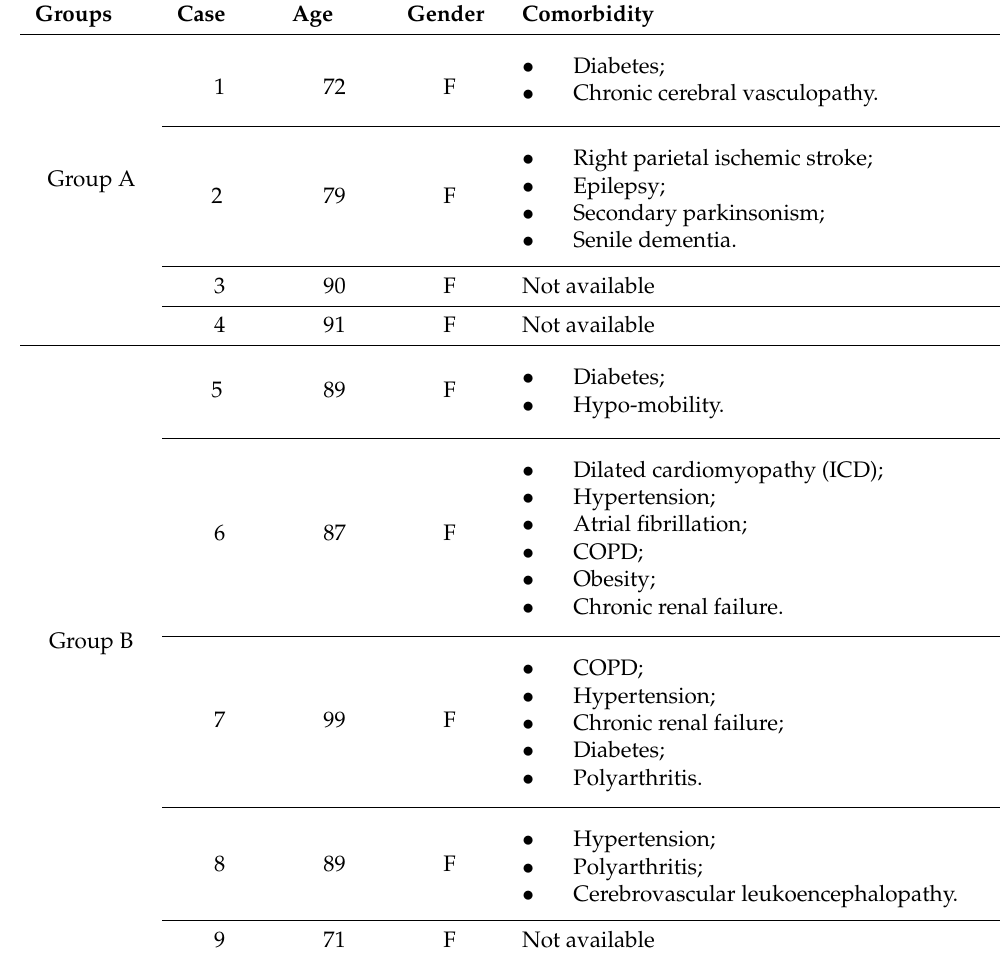
Table 1. Clinical characteristics of the study